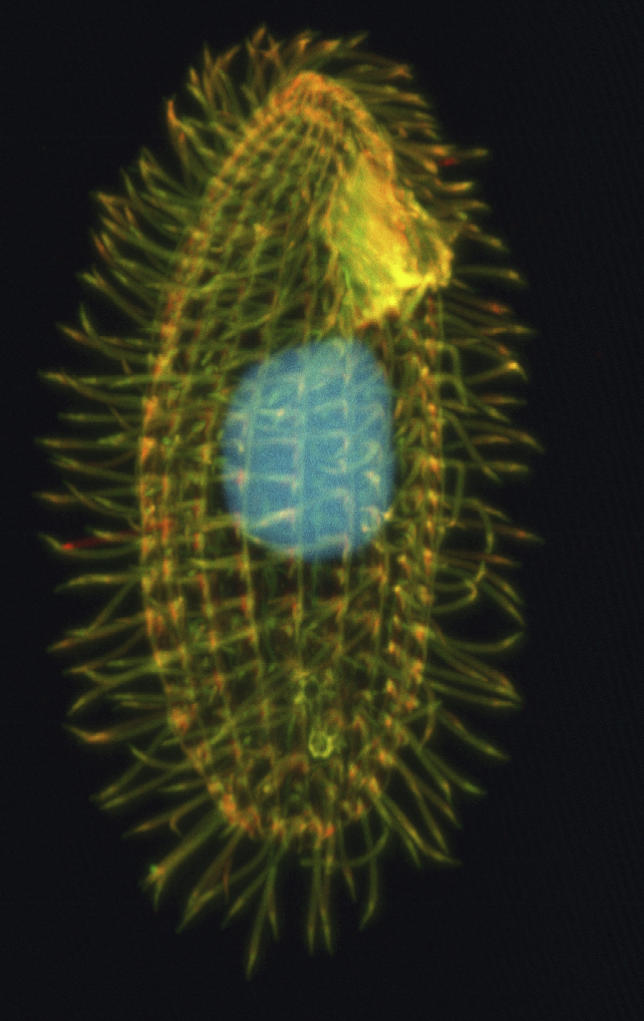
The genome sequence of the single-celled ciliate Tetrahymena thermophila sheds light on early eukaryotic evolution.